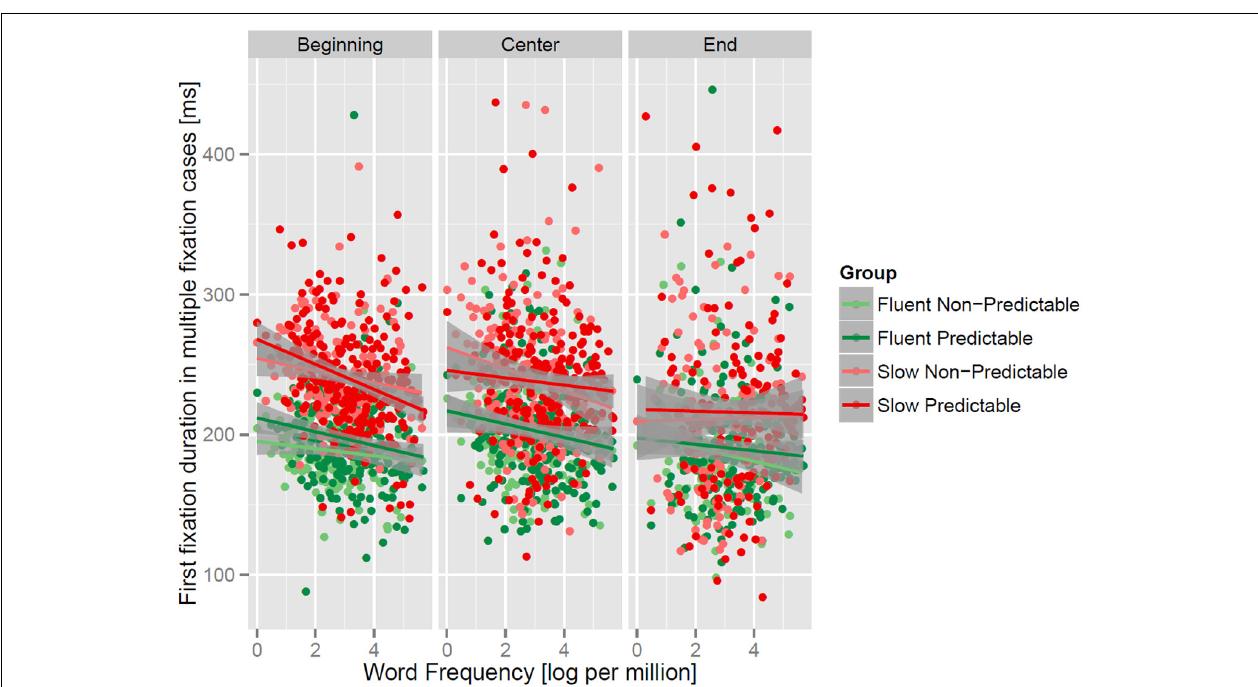
FIGURE 4 |The first fixation duration of multiple fixation cases in relation to word frequency for both groups, landing position and respective regression lines with confidence intervals for predictable (predictability > 0) and unpredictable words